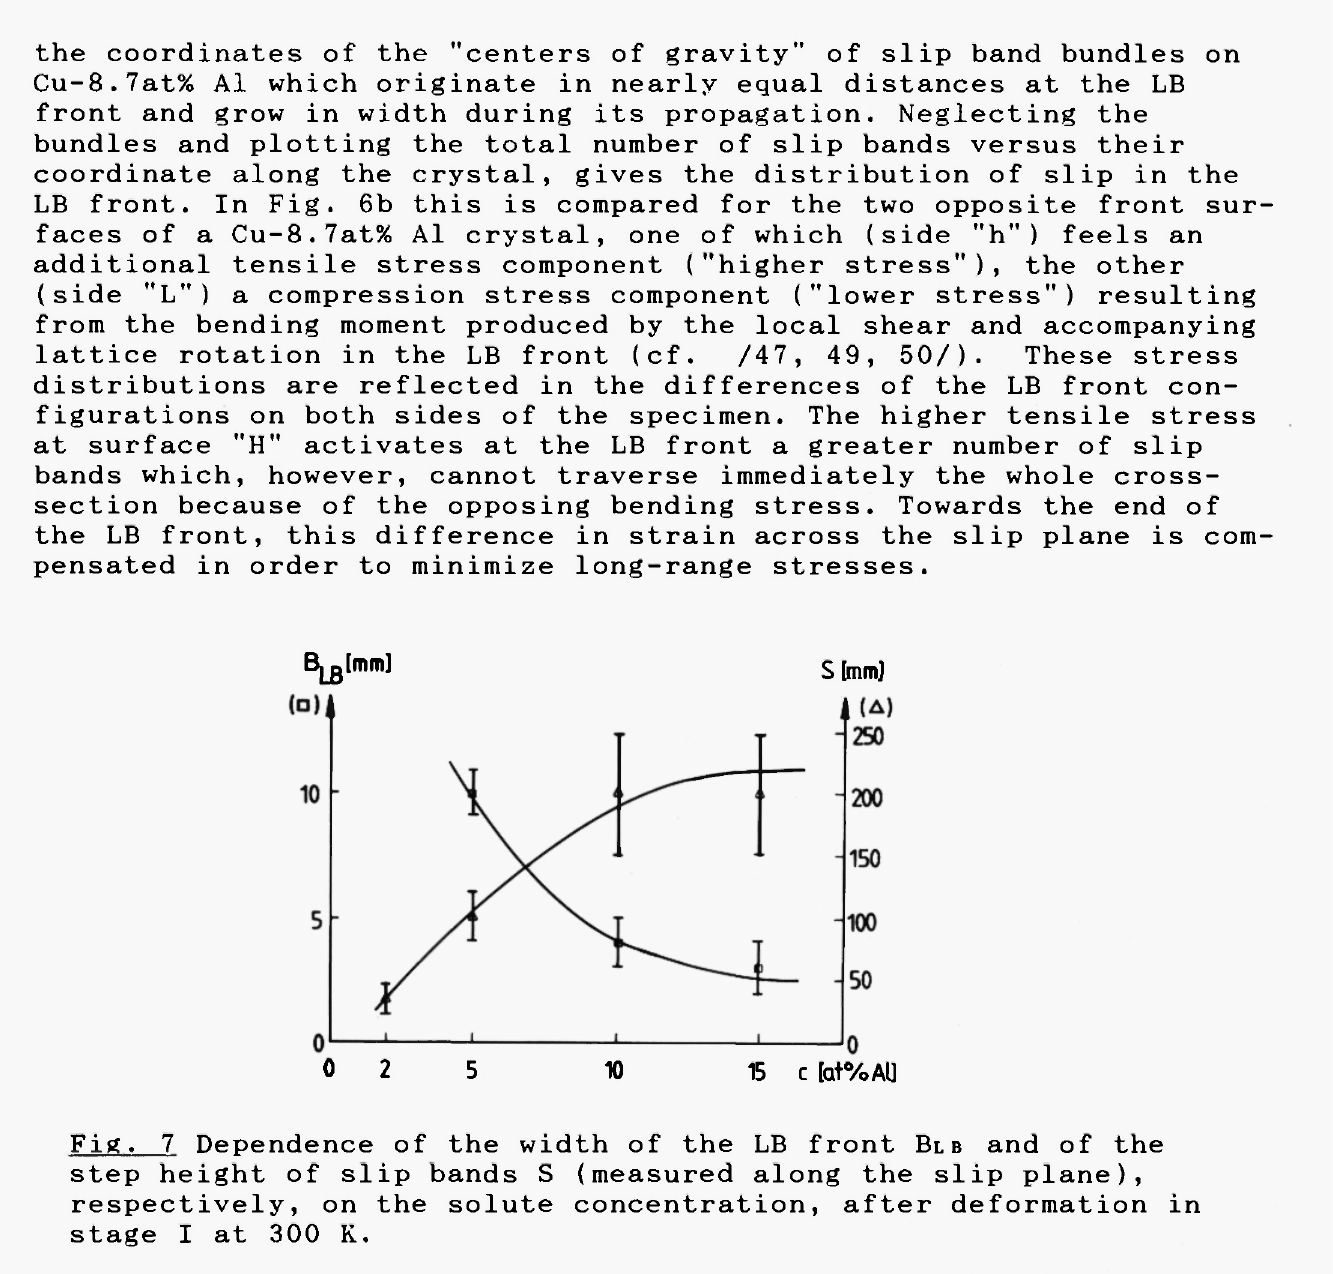
Fig. 7 Dependence of the width of the LB front B lβ and of the step height of slip bands S (measured along the slip plane), respectively, on the solute concentration, after deformation in stage I at 300